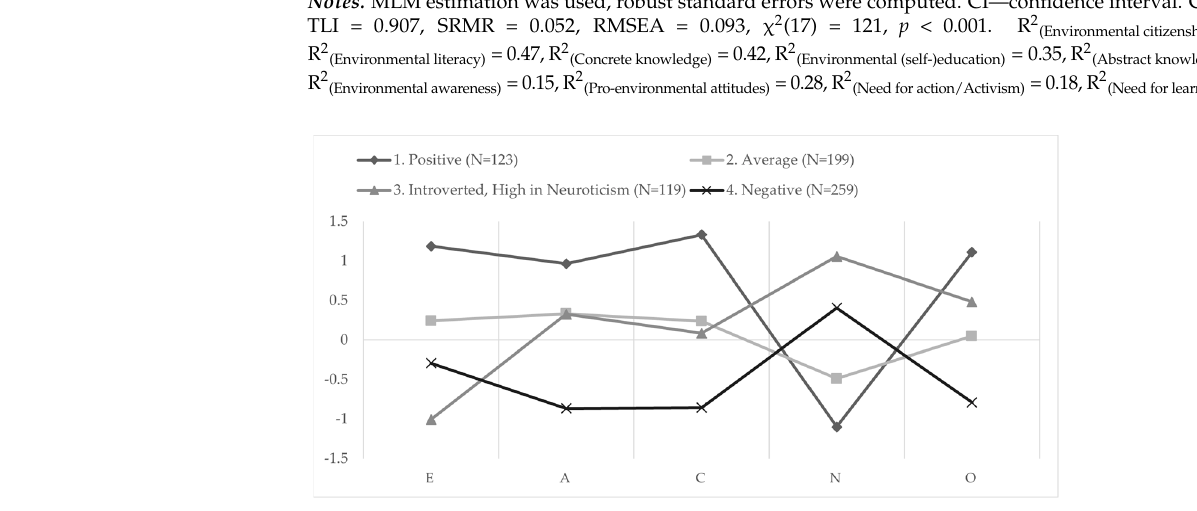
Figure 2. Cluster profiles based on the Big Five personality traits. The four clusters differ qualitatively, with the Positive cluster grouping individuals with traits that are usually considered more socially desirable and the Negative cluster grouping individuals with traits that are usually regarded as less socially desirable [39,40]. The Average cluster is characterized by having mostly average expressions regarding all traits and tending to be slightly more emotionally stable than the average. The ‘Intro- verted, High in Neuroticism’ cluster consists of individuals that tend to keep to them- selves and are less emotionally stable as well as more cautious. It needs to be emphasized that all personality trait patterns have adaptive value and simply result in different strat- egies that individuals take toward achieving their goals [37,41,42]. A further analysis (see Appendix A, Table A1) indicated that the sexes are not equally represented in each cluster, with cluster 3 being more common for females and cluster 4 being more common for males. Such differences, however, are expected since there are robust evidence of person- ality differences between the sexes and the clustering solution is consistent with the liter- ature on these differences [43,44]. Prior to conducting a multigroup SEM analysis, a series of ANOVAs were run to see whether the identified clusters differ significantly regarding the variables of the model. In